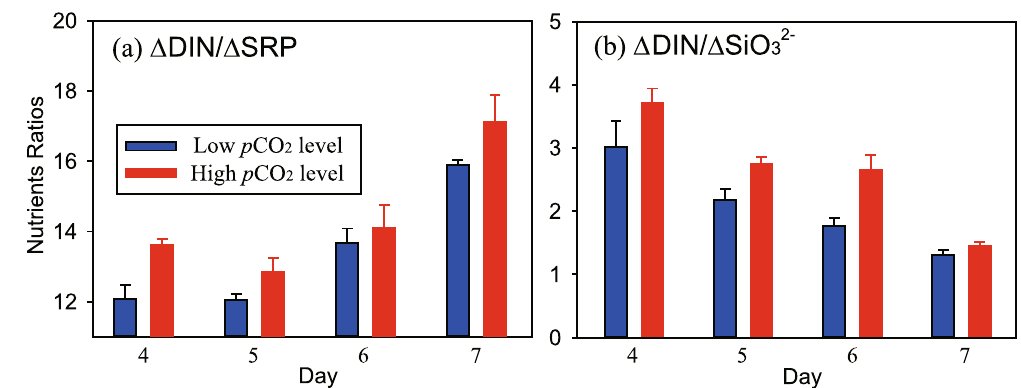
Figure 5. Temporal variations in nutrient consumption ratios of dissolved inorganic nitrogen to soluble reactive phosphorus ( a , Δ DIN/ Δ SRP) and to SiO 32 − ( b , Δ DIN/ Δ SiO 32 − ) during the nutrients replete period (day 4–7) in 6 seawater enclosures which were perturbed by bubbling with ambient air (400 ppmv CO 2 , Low CO 2 level) or an air/CO 2 mixture at a concentration of 1000 ppmv CO 2 (High CO 2 level). Columns are the means and error bars are the standard errors of three replicate